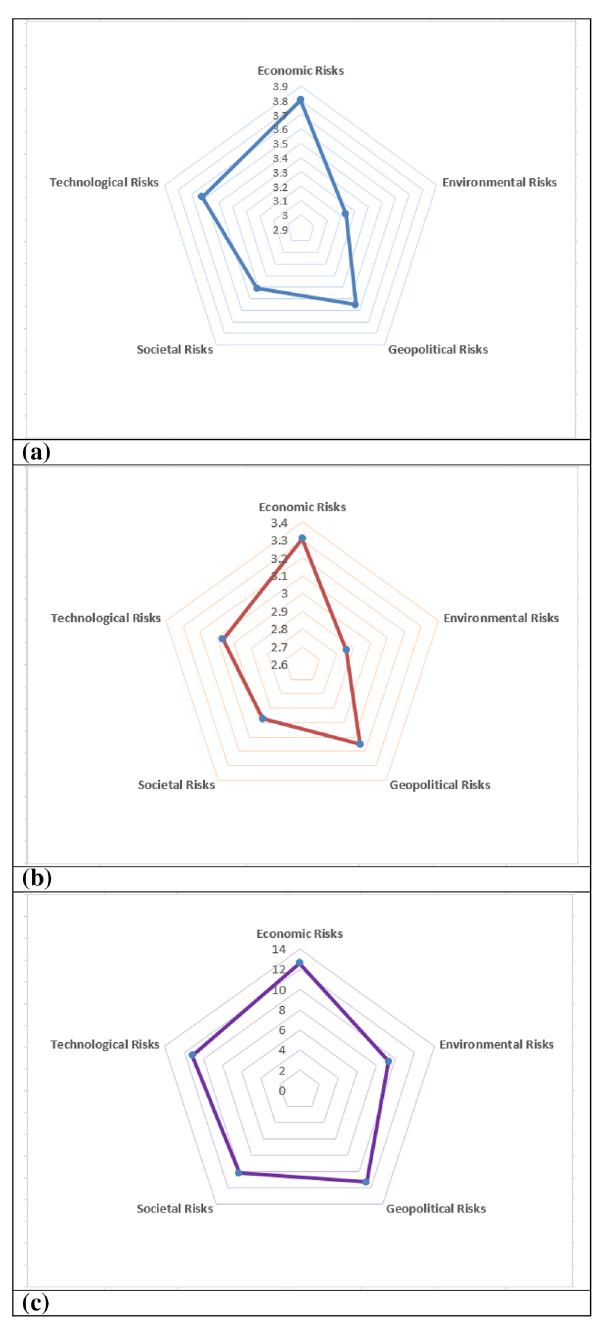
Fig. 6 Radar diagram for global risk likelihoods ( a ), risk impacts ( b ), and risk values (likelihood 9 impact) ( c ) perceived by the surveyed small and medium enterprises in